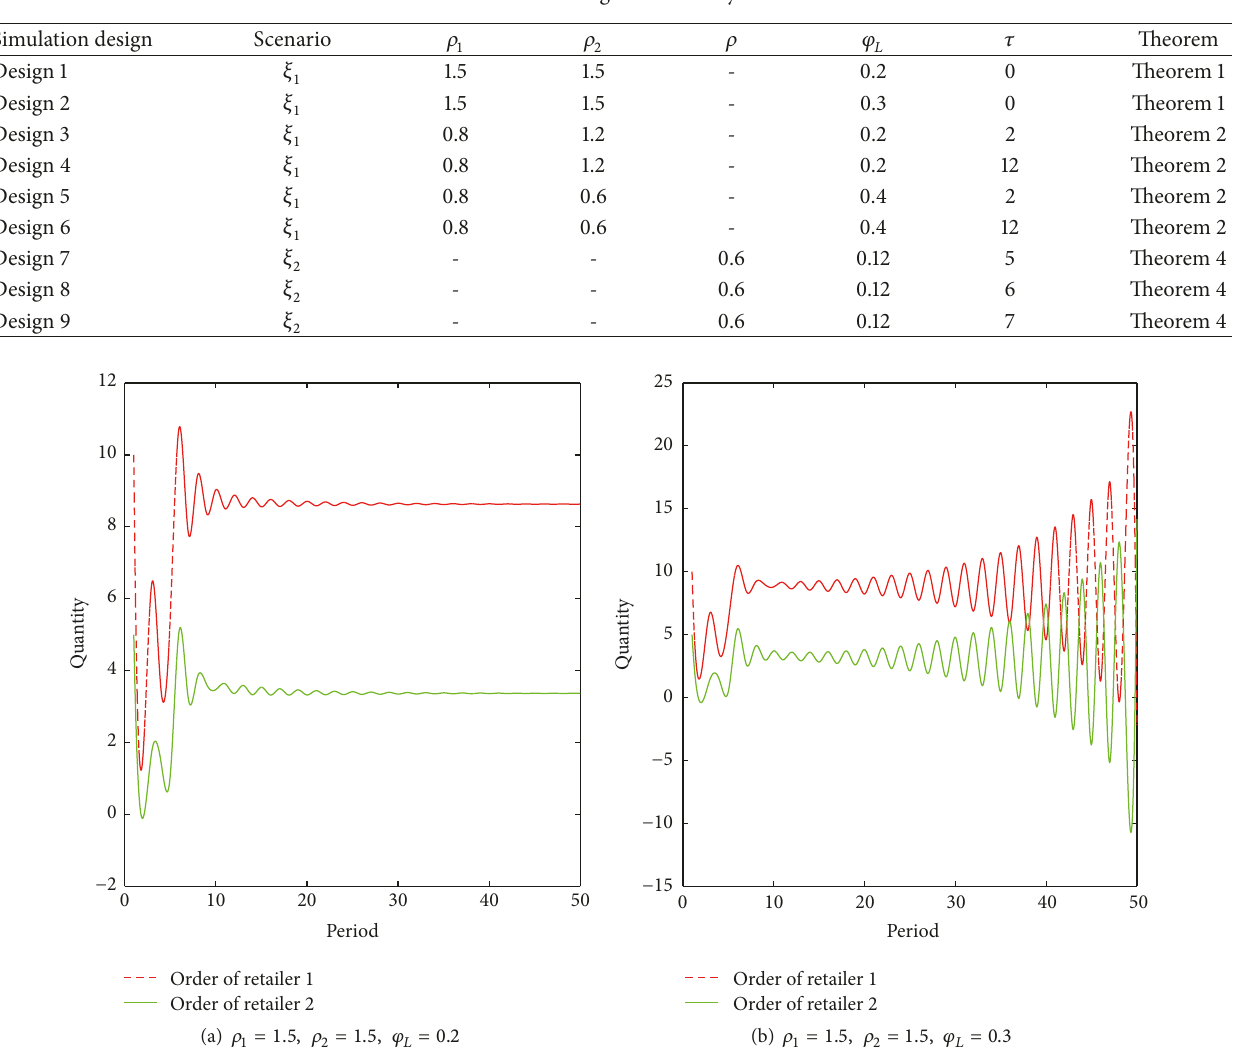
Table 1: Simulation designs for stability validation.